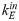
Motif 1 autocatalytic integral controller.The controller species E is produced by an enzymatic zero-order process from compound M, but E activates its own production and the transporter-based compensatory flux. The negative feedback is due to the inflow activation of A by E through transporter T, while A activates the (first-order) recycling of E to M. Outflow perturbation in A is described by the rate k3⋅A, where k3 is either a constant or increases linearly with time. kEin and kEout represent background reactions creating and removing E.